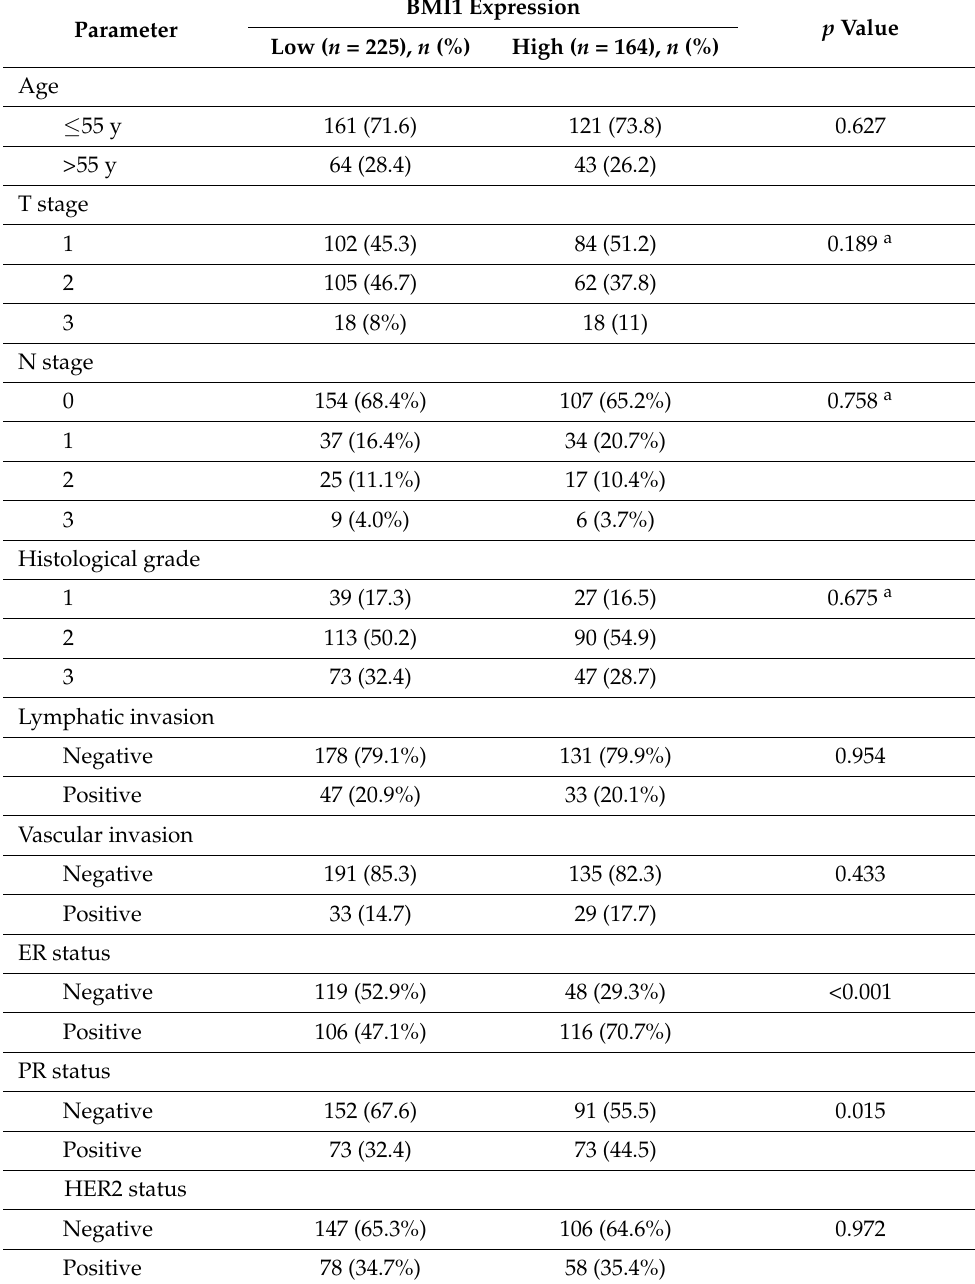
Clinicopathological parameters of patients in the KBSMC cohort stratified by BMI1